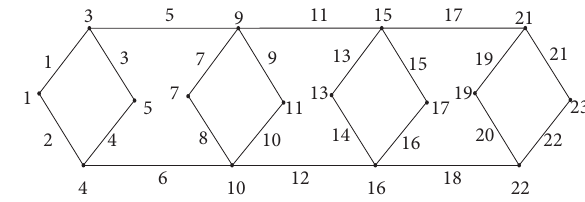
Figure 15: A classical mean labeling of D ∗